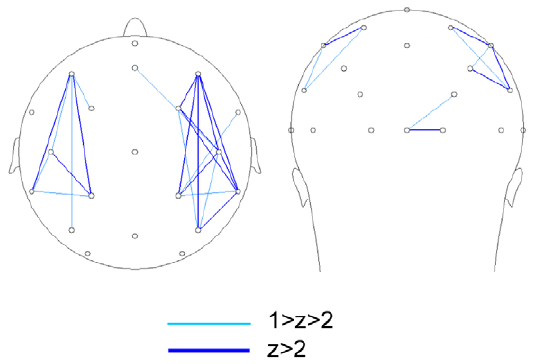
Figure 4. Fronto-parietal Coherence Network. Pairs of electrodes showing higher mu-frequency coherence during the observation of movement sequences than during the pause intervals. Only electrode pairs with the largest normalized coherence effects (1 . z . 2, z . 2) are shown.